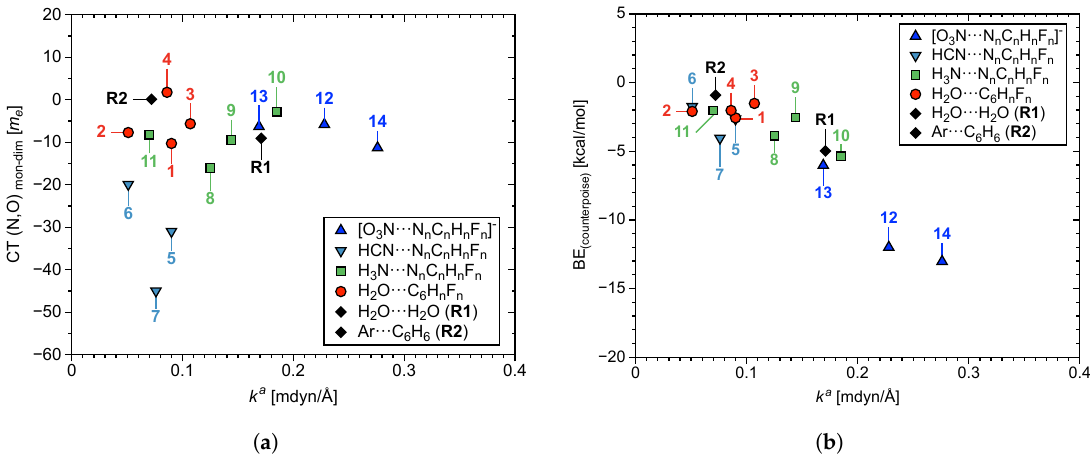
Figure 5. ( a ) CT (from central π –hole acceptor atom O in 1–4 , N in 5–14 , Ar in R2 , and HB acceptor atom O in R1 −−→ donor), and ( b ) BE, counterpoise corrected for basis set superposition error; both plotted with respect to k a of π –hole interactions in